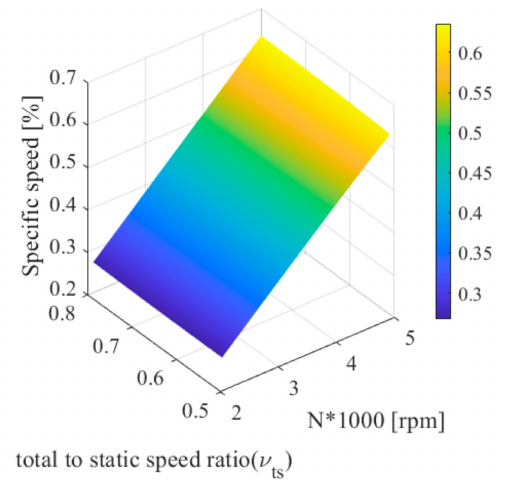
Figure 11. Variation of the specific speed with total to static speed ratio and rotor